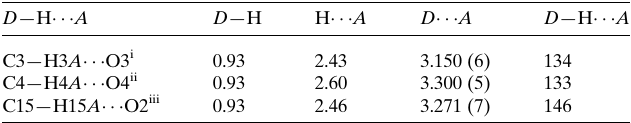
Table 1 Hydrogen-bond geometry (A˚ , (cid:2)